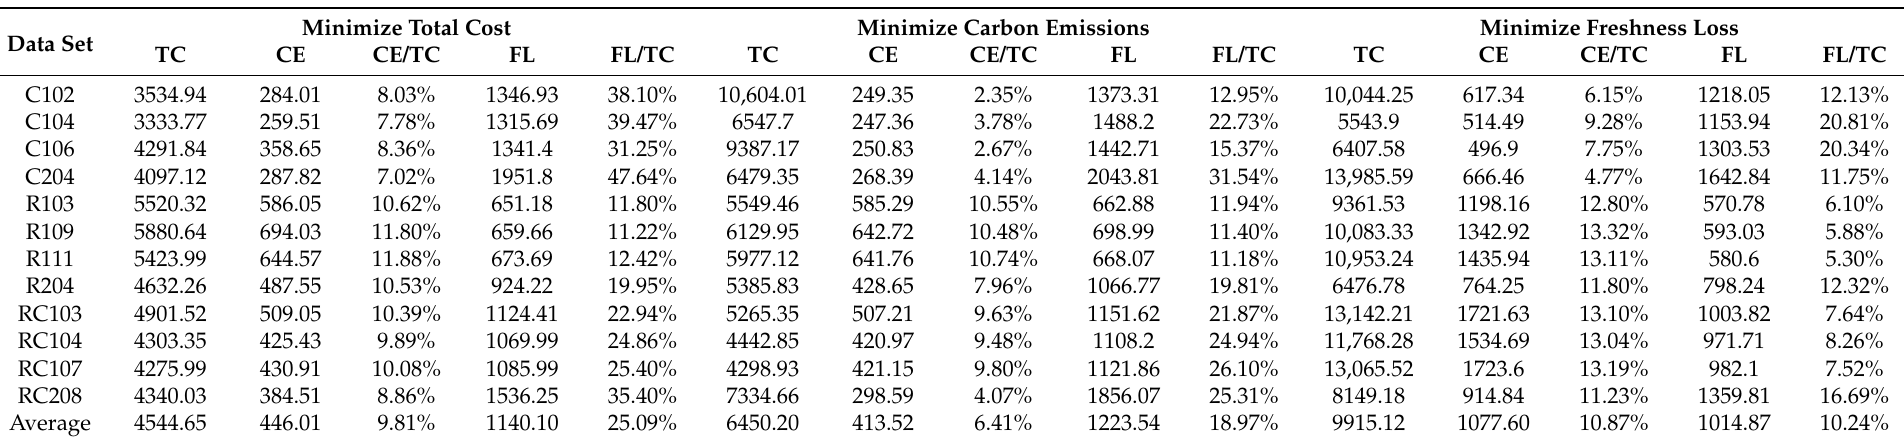
Table 3. Comparison of experimental results of different optimization